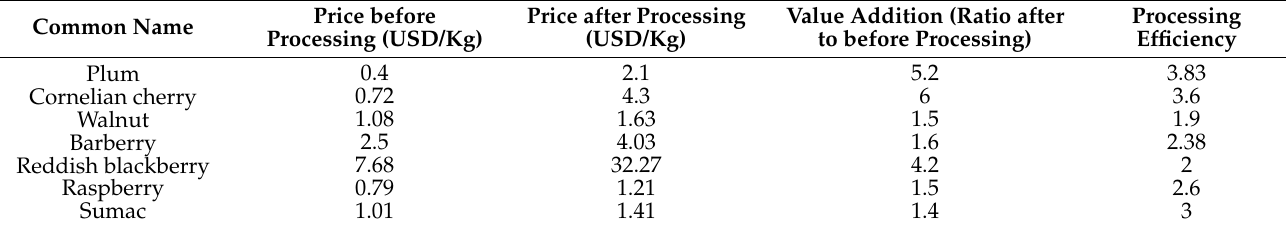
Table 3. Value addition of NTFPs processing and processing